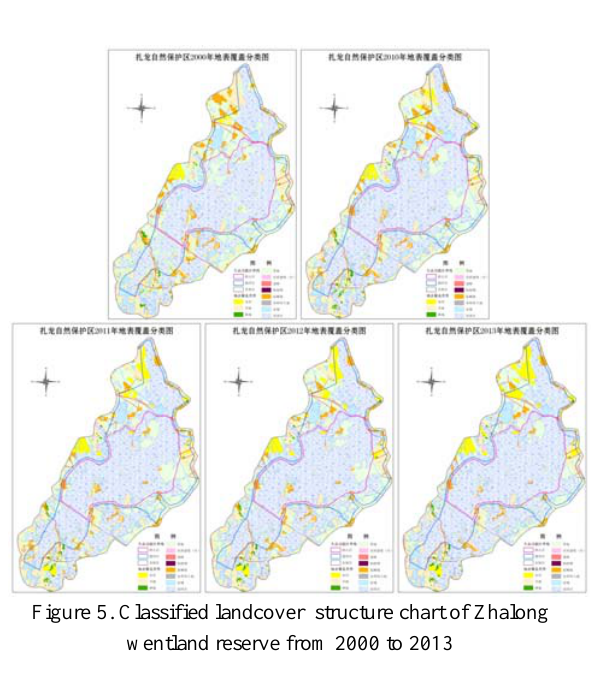
Figure 5. Classified landcover structure chart of Zhalong wentland reserve from 2000 to 2013